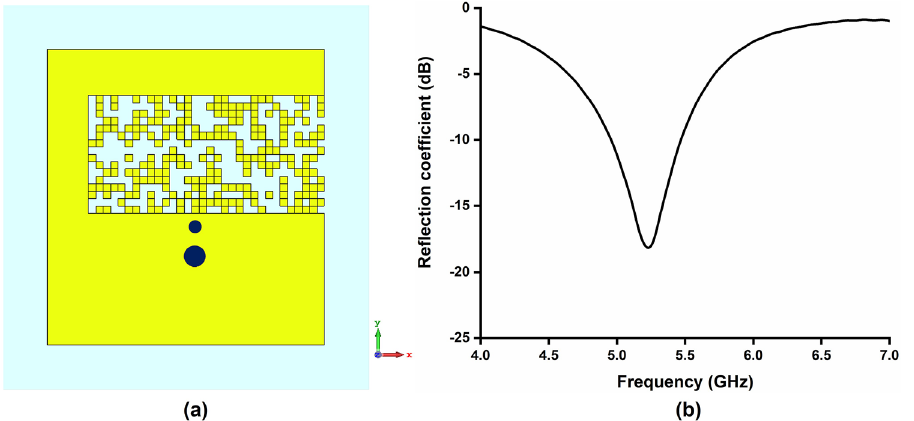
Figure 7. ( a ) Pixelated layout of Antenna B (5.2 GHz), Software used: CST Microwave Studio 2019 ( b ) reflection coefficient of Antenna